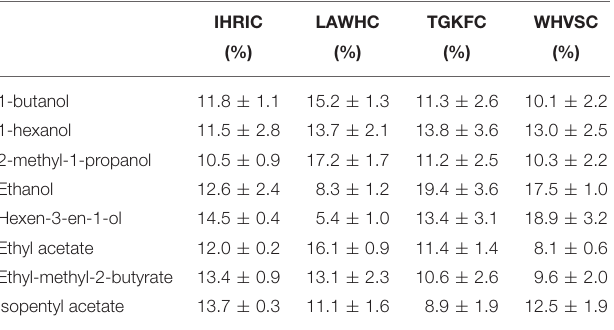
TABLE 3 | Percentage of the normalized frequency shift of the four peptide-modified sensors vs. the eight volatile compounds. IHRIC LAWHC TGKFC WHVSC